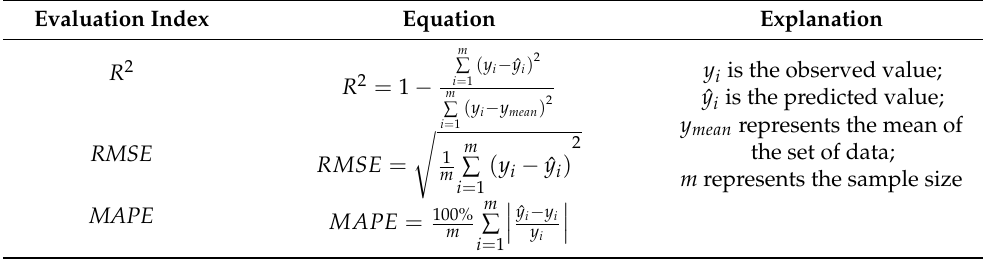
Table 4. Evaluation index.